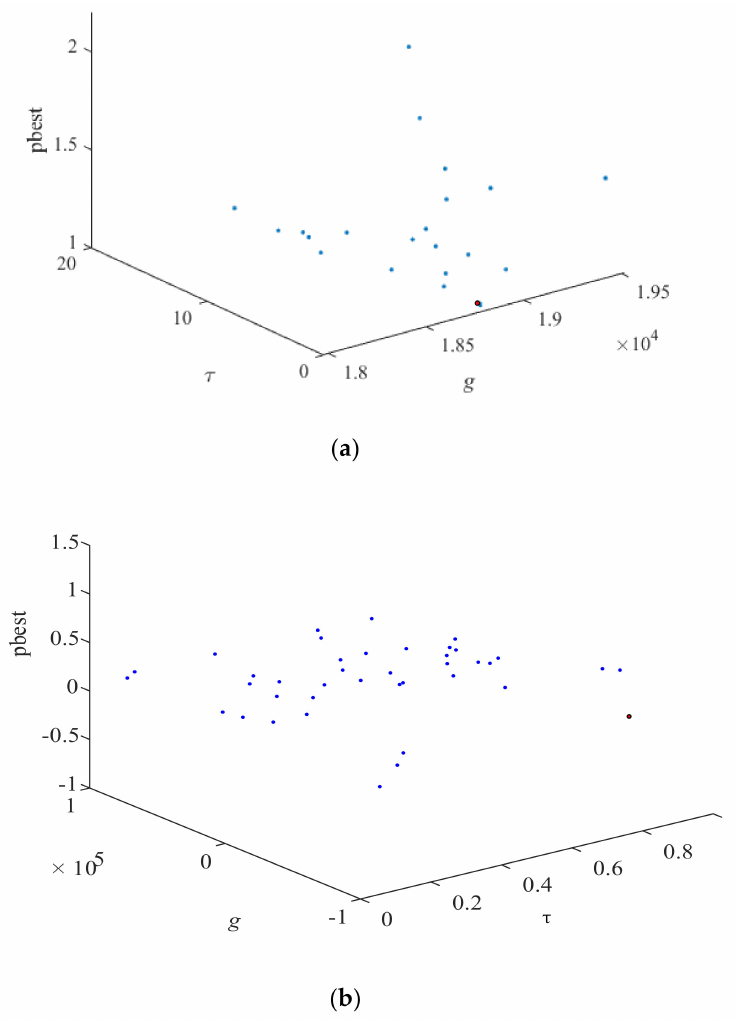
Figure 5. Time-delay control parameter-change diagram. ( a ) Time-delay parameter-change diagram under harmonic excitation. ( b ) Time-delay parameter-change graph under random